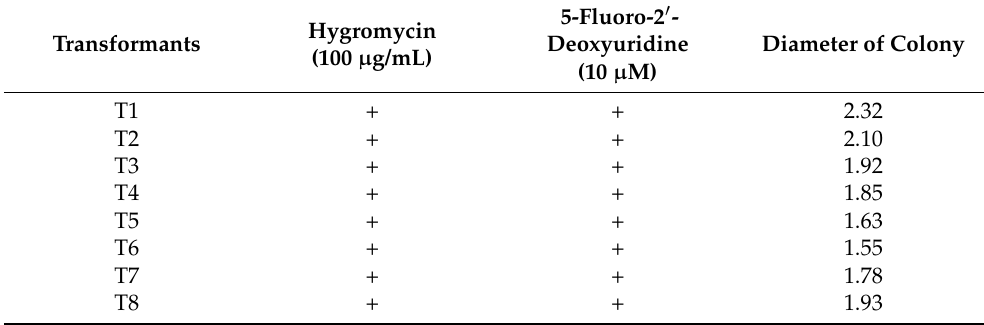
Table 2. The resistance screening of aldh disrupted transformants using dual selectable markers. The mutants (T1–T8) were selected on PDA plate medium containing 100 µ g/mL hygromycin, and then regenerated in the presence of 100 µ g/mL hygromycin and 5-fluoro-2 (cid:48) -deoxyuridine (F2dU). +: growth.